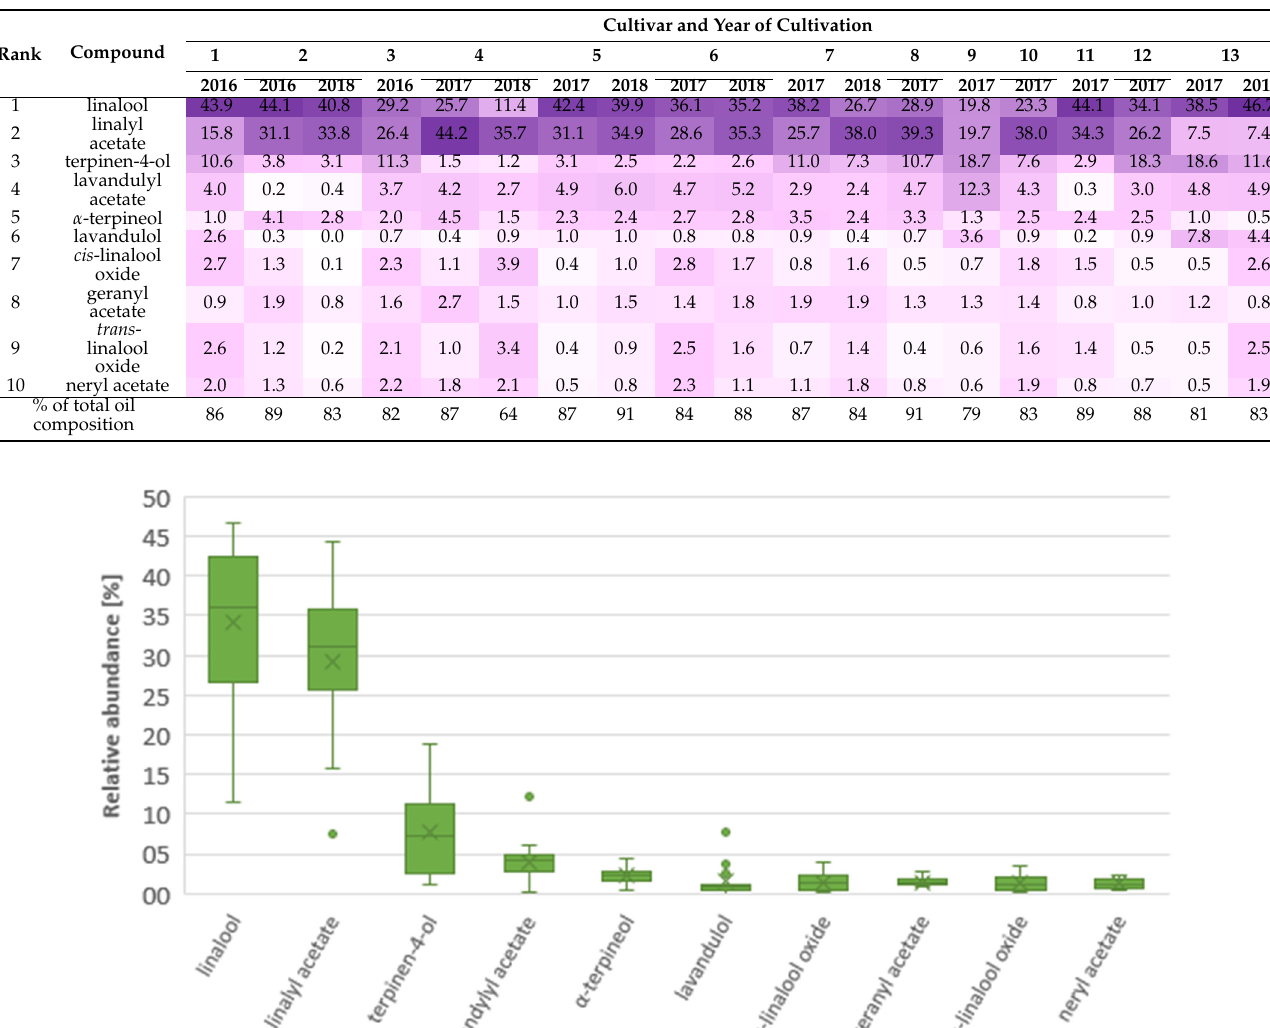
Table 3. Top ten components in the essential oils of the studied lavenders cultivars. All of the figures represent % abundance. The components are listed in descending order of the sum of % abundance for each component.